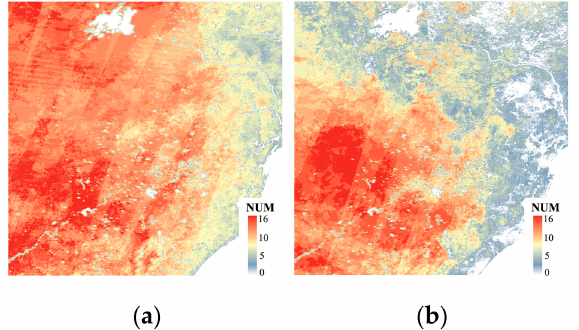
Figure 12. The number of observations in each pixel at the two periods: ( a ) refers to the observations within 2021.101-116; and ( b ) refers to the observations within